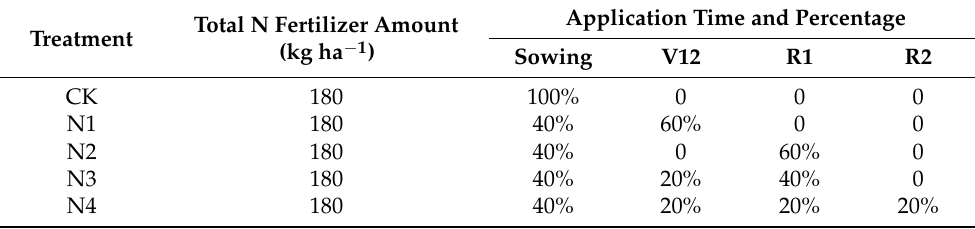
Table 1. N fertilizer treatments in 2016 and